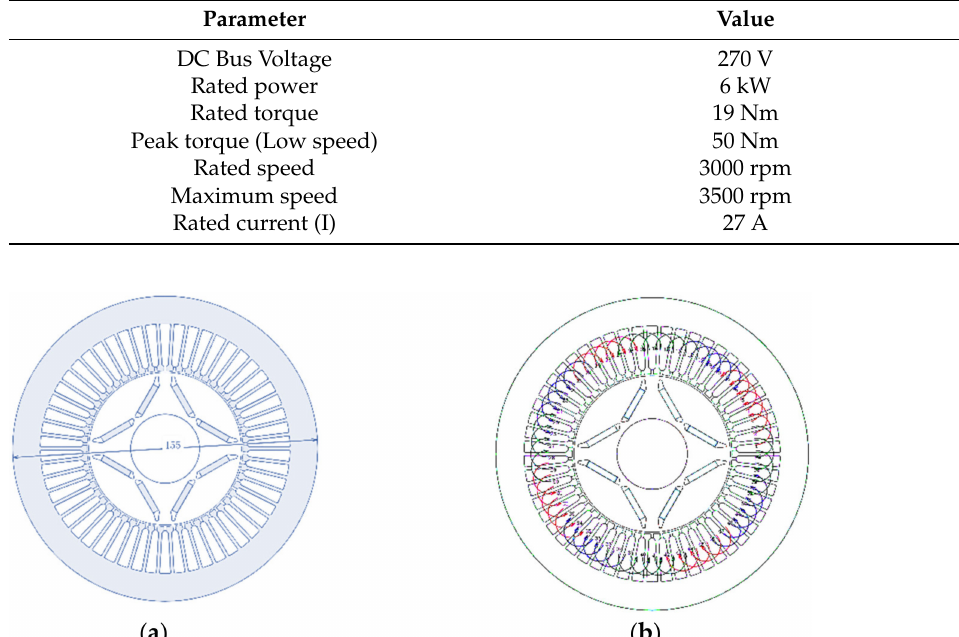
Table 1. Main parameters of motor.